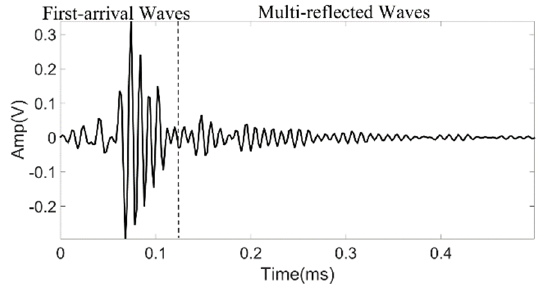
Figure 5. Ultrasonic signal inside a sealed container.